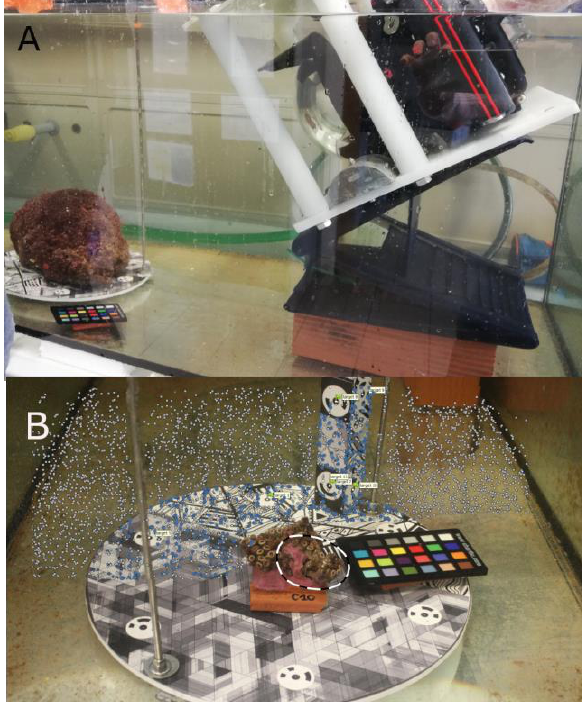
Figure 1 . A- Set-up of photogrammetric acquisition. B- view of the sample and the colour checker positioned over the support with targets; The white and blue points, only depicted in a portion of the image, represent the identified keypoints and tie points, respectively; the dashed circle highlights the area affected by mechanical stress.